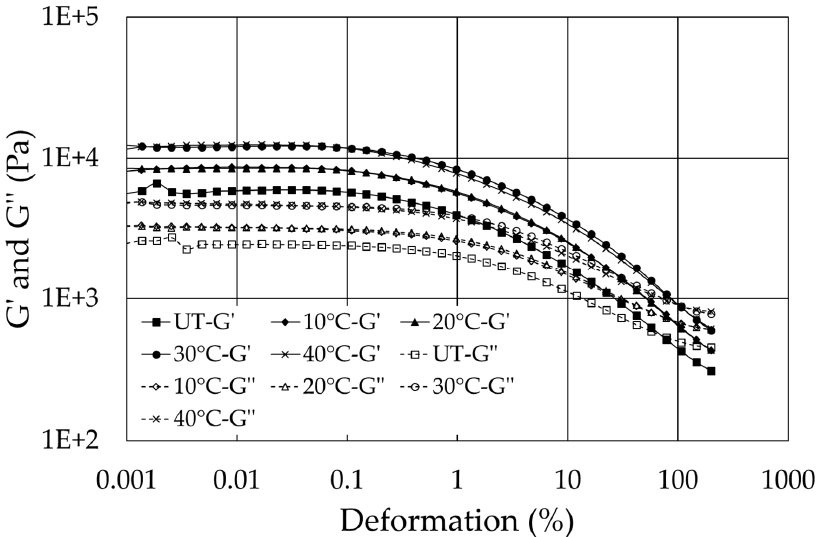
Figure 9. Change in the storage (G ′ ) and loss (G ′′ ) moduli of wheat dough as a function of environ- mental (air) temperature.